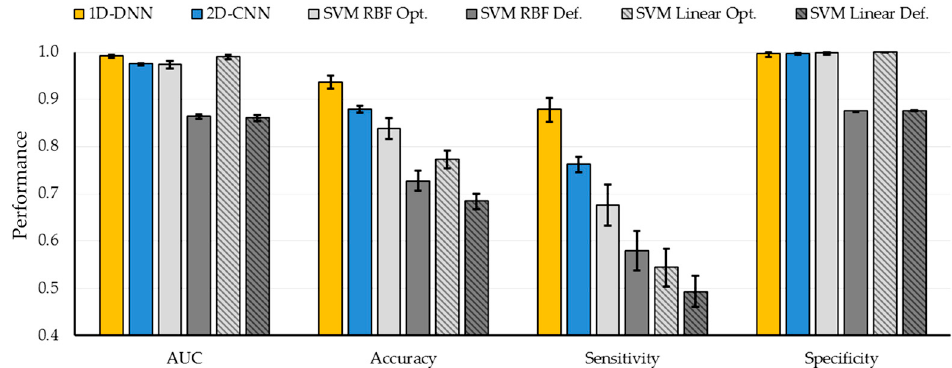
Figure 6. Average results of the leave-one-out cross-validation of the binary dataset obtained for each classification approach using the class-balancing and bootstrapping method with the 95% confidence interval.